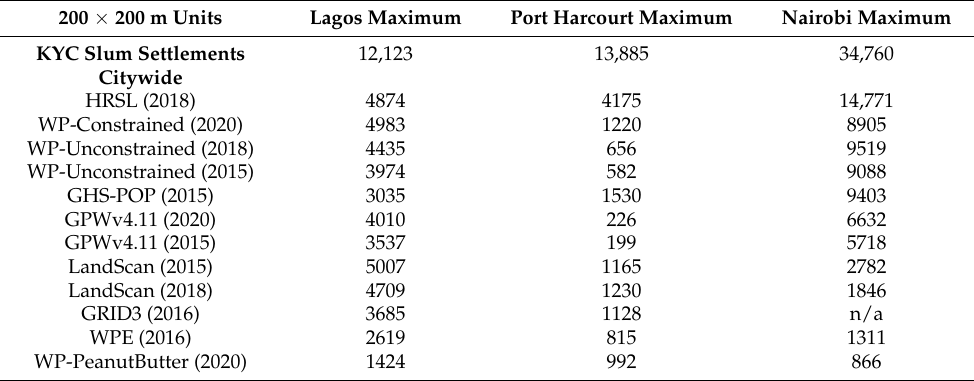
Table A2. Population densities in 200 × 200 m areas across 118 KYC slum settlements as well